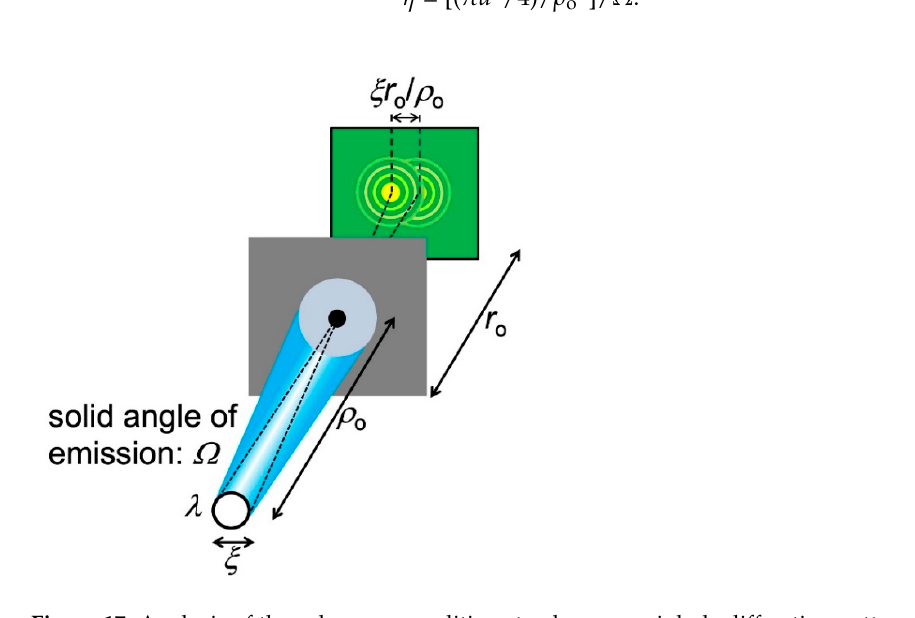
Figure 17. Analysis of the coherence conditions to observe a pinhole diffraction pattern when the source has an extended area.